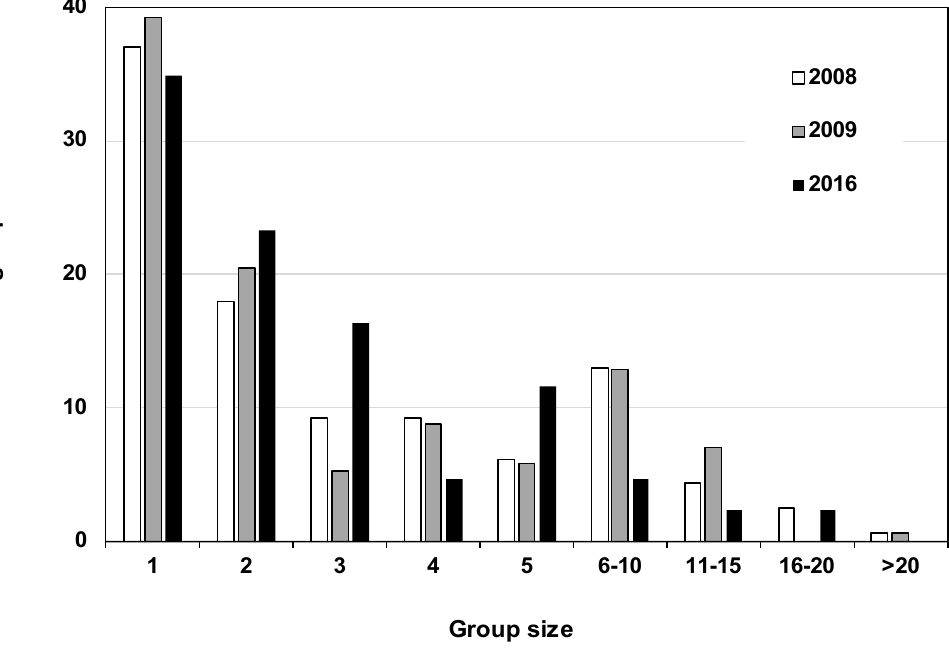
Figure 2. Summer group sizes of muskoxen in Jameson Land reported during the bird surveys of 2008 and 2009 (from Glahder et al., 2010) and our ground count in